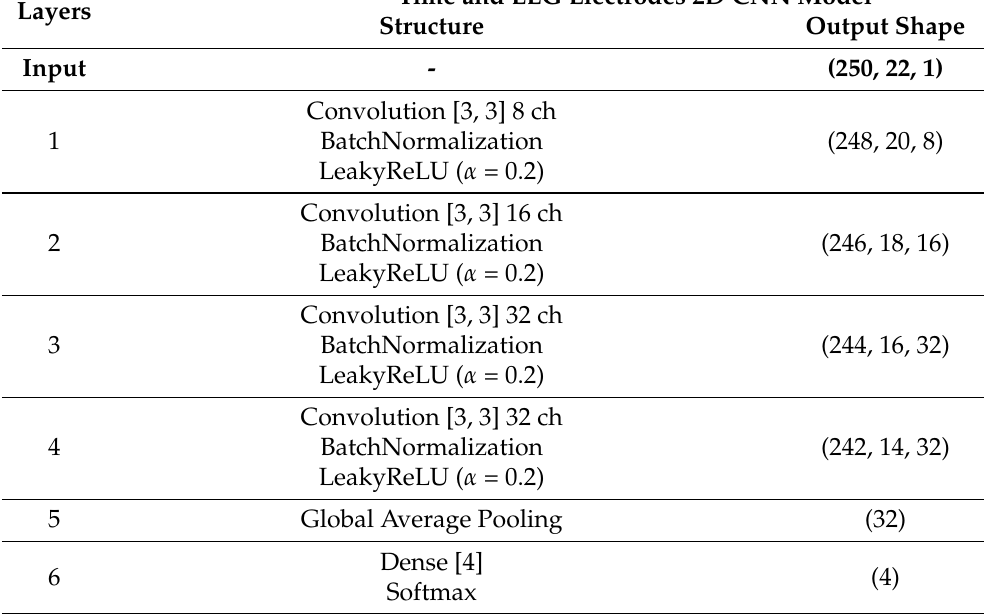
Table 3. The model structure of Time and EEG electrodes axis 2D